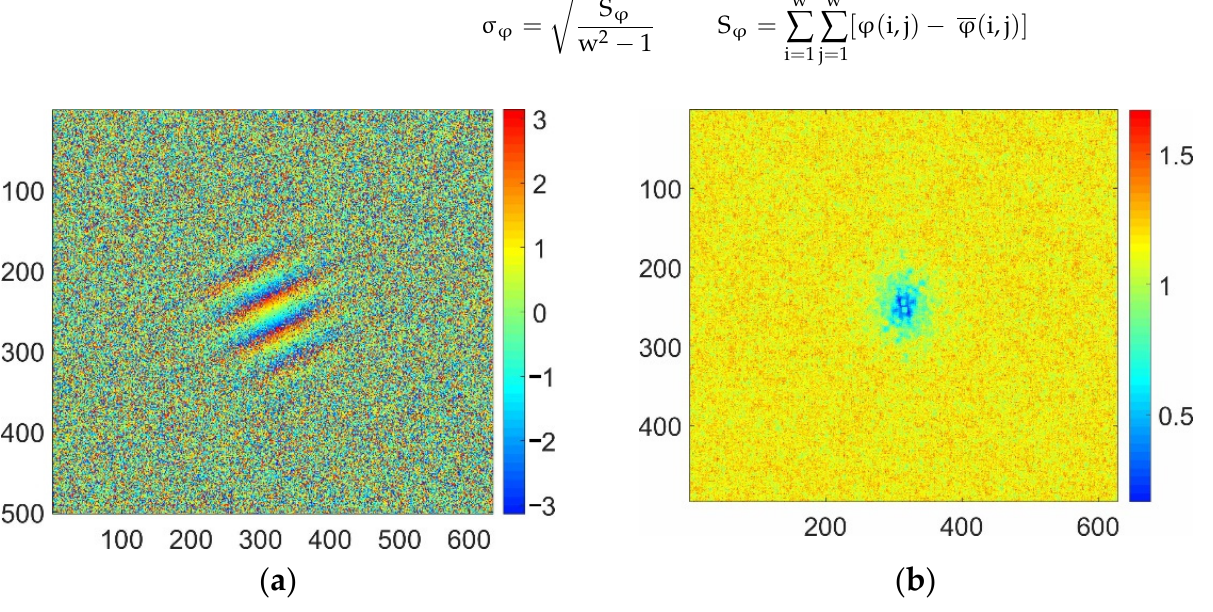
Figure 3. Cross-power spectrum and corresponding PSD, where ( a ) is the cross-power spectrum matrix’s phase, and ( b ) is the PSD matrix.